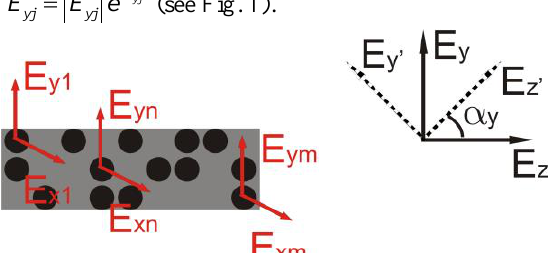
Fig. 1 Schematic view of the gas (gray rectangle) with at- oms (black circles) emitting the THz field (red arrows indi- cate two projections). By the black solid arrows and black dashed arrows indicated the two projections of the field formed by the sum of projections of the single color field on  denotes the rotation the one axes. y